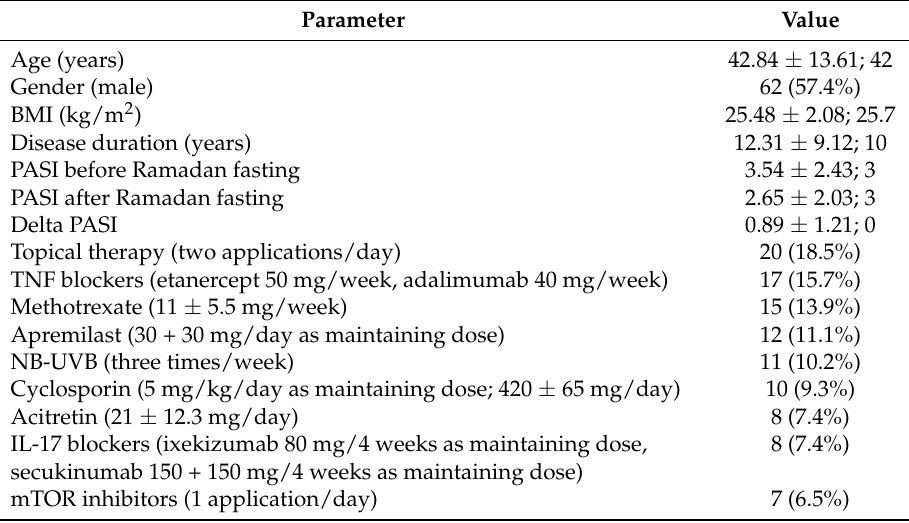
Table 1. Main characteristics of the recruited